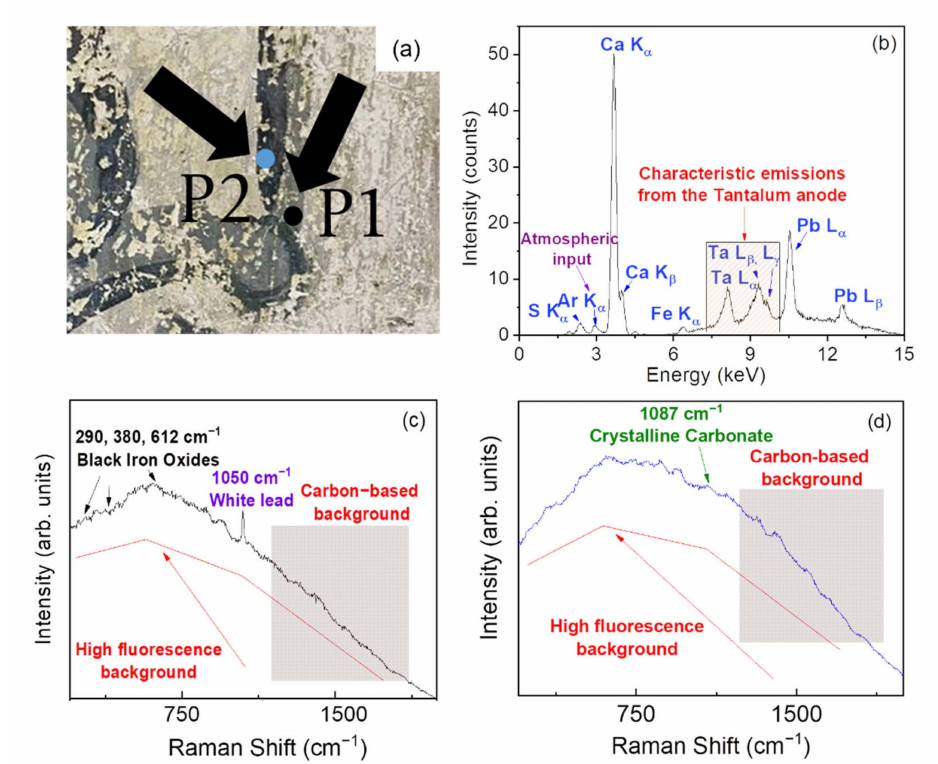
Figure 3. Photos of the points P1 (light gray) and P2 (dark gray) ( a ). XRF spectrum recorded on the point P1, reported as an example ( b ). Raman spectra recorded on points P1 and P2, respectively ( c , d ). The XRF spectrum collected on point P3 almost completely matched that of